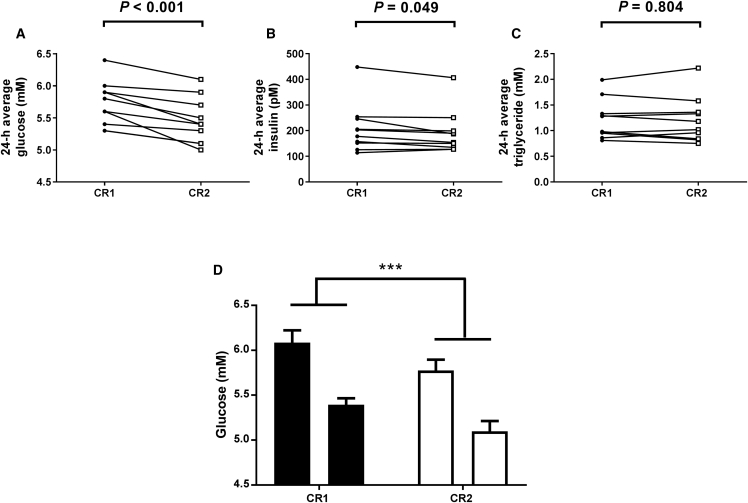
The Average Plasma Glucose Concentration in Constant Routine Conditions Is Reduced Following a 5-hr Delay in Meal Times(A–C) 24-hr average concentration of glucose (A), insulin (B), and triglyceride (C) in plasma samples collected in constant routine conditions following early meals (CR1; black circles) and following a 5-hr delay in meal time (CR2; white squares). There was a significant decrease in the mean glucose concentration following late meals (5.45 ± 0.11 mmol/L) compared to early meals (5.72 ± 0.11 mmol/L, t(9) = 5.22, p < 0.001, paired t test). Following Bonferroni correction of the critical p value, there was no significant decrease in the mean concentration of plasma insulin following late meals (208.2 ± 30.46 versus 192.6 ± 26.75 pmol/L, early versus late, respectively; t(9) = 2.27, p = 0.049, paired t test). There was no significant difference in mean triglyceride concentration (1.22 ± 0.12 versus 1.21 ± 0.14 mmol/L, early versus late meals, respectively; t(9) = 0.26, p = 0.804, paired t test).(D) Peak and trough concentration of glucose in plasma samples collected in constant routine conditions following early meals (black bars) and a 5-hr delay in meal time (white bars). Using two-way repeated-measures ANOVA, there was an overall significant effect of meals (F(1, 9) = 22.98, p = 0.001), a significant difference between peak and trough values (F(1, 9) = 177.6, p < 0.001), but no significant interaction between the two factors (F(1, 9) = 0.01, p = 0.914). ∗∗∗p < 0.001 (early meals/CR1 versus late meals/CR2). Data are plotted as mean ± SEM.(A–D) Statistical significance is defined as p < 0.01 (following Bonferroni correction for analysis of plasma concentration in five markers). Data are from n = 10 participants.